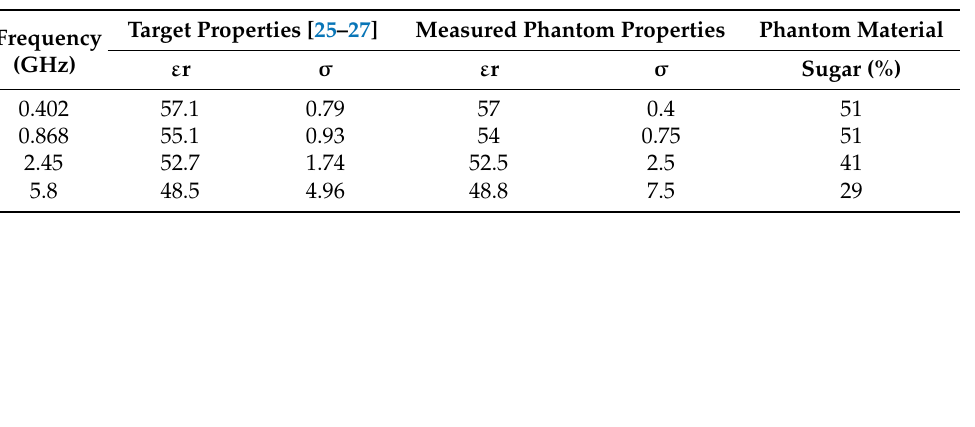
Table 4. Fabricated muscle phantom properties for the frequencies of